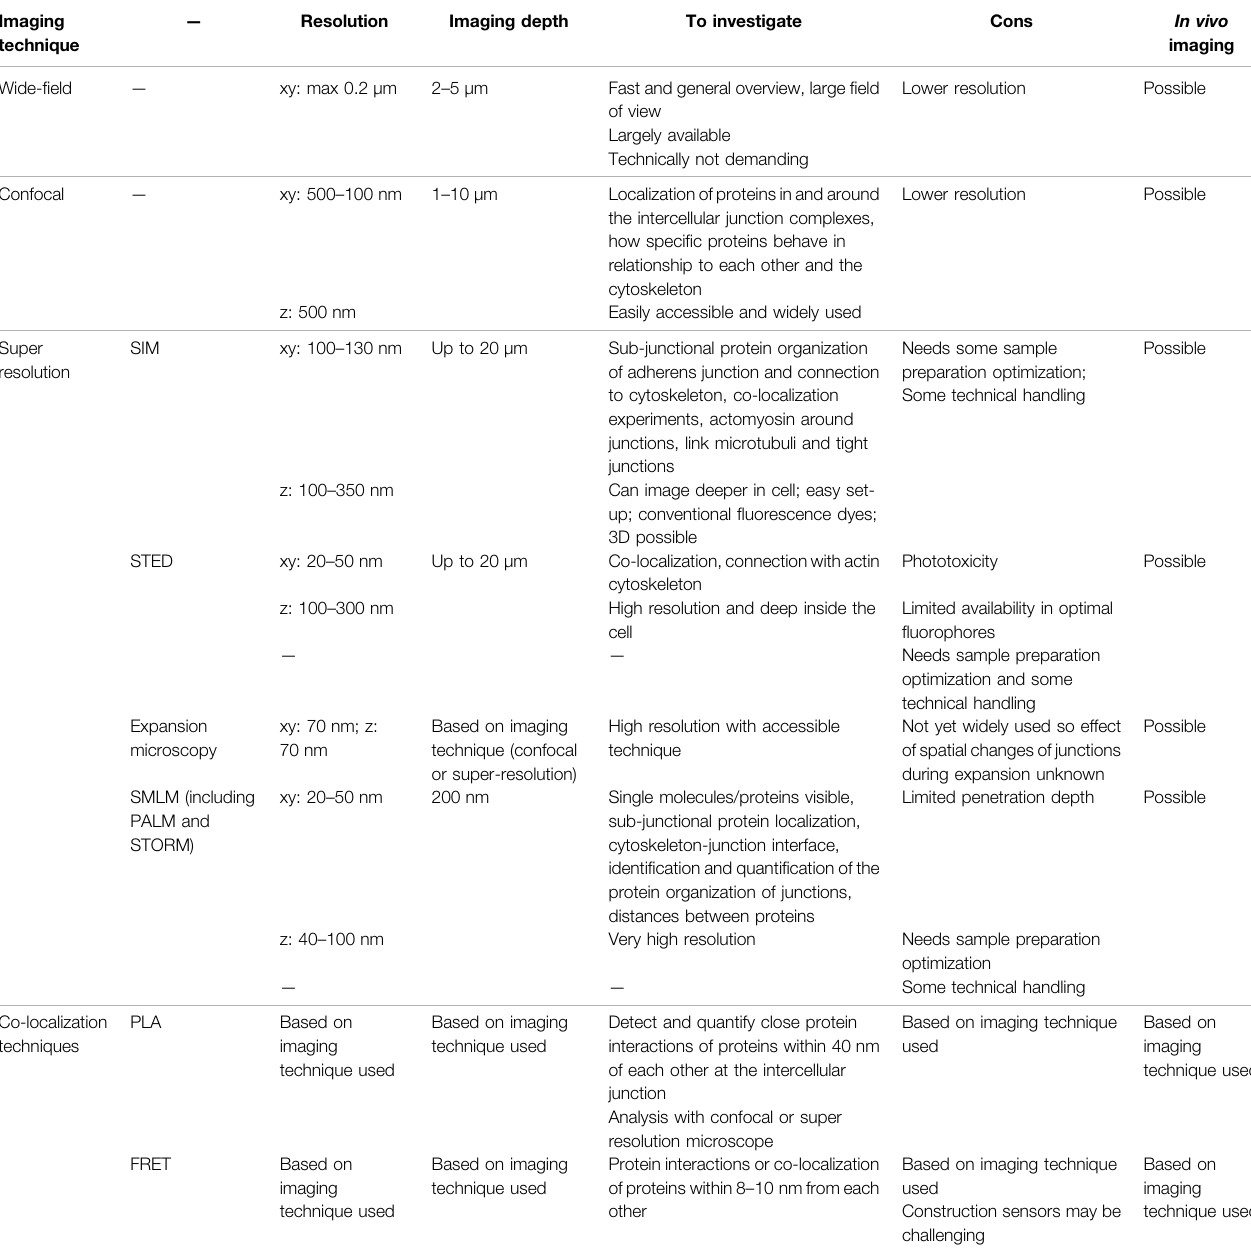
TABLE 1 | An overview of the imaging techniques used to study the structure and composition of cell-cell adhesions with light-based microscopy. SIM: structured illumination microscopy; SMLM: single-molecule localization microscopy; PALM: photoactivated localization microscopy; STORM: stochastic optical reconstruction microscopy; STED: stimulated emission depleted; PLA: proximity ligation assay; FRET: fl uorescence resonance energy transfer. Imaging